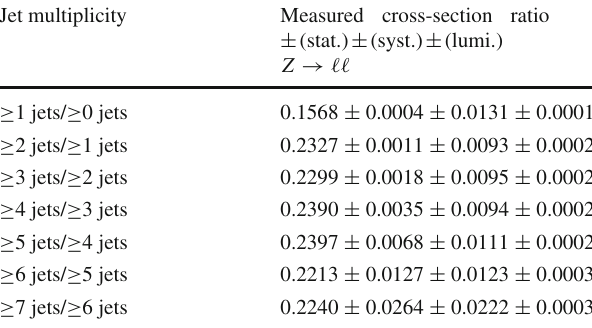
Table 6 Measured combined ratios of the fiducial cross sections for successive inclusive jet multiplicities. The statistical, systematic, and luminosity uncertainties are given Jet multiplicity Measured cross-section ratio ± (stat.) ± (syst.) ±